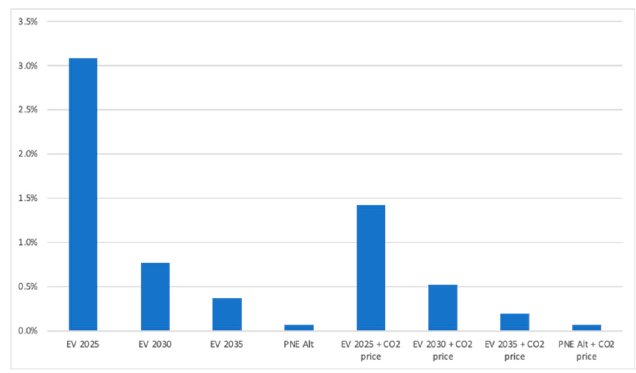
Figure 5. Additional overall electricity demand for di ff erent time frames of EV adoption—comparison with reference scenarios (with and without a CO 2 price).